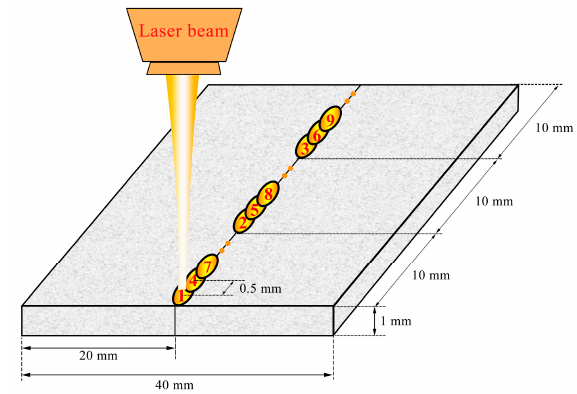
Figure 2. Schematic illustration of welding strategies.